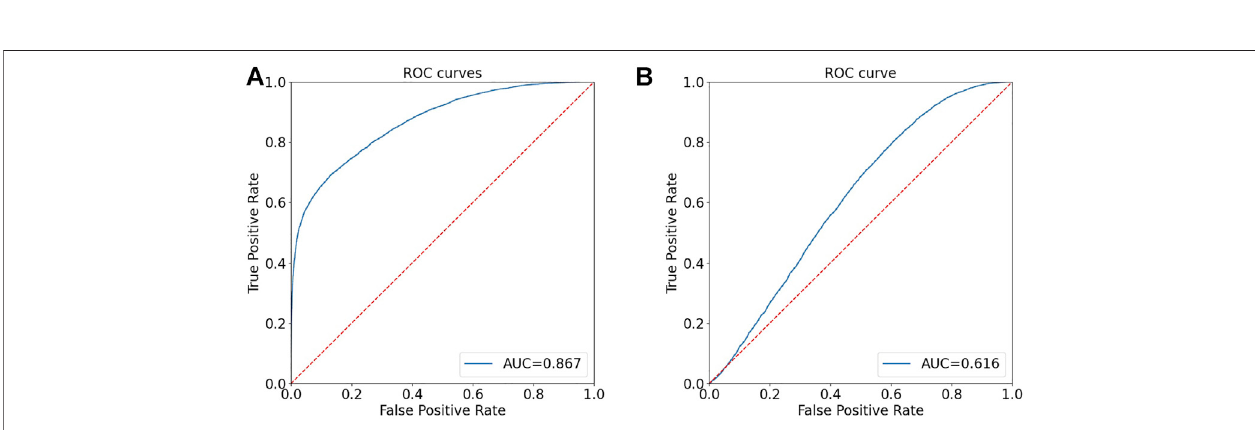
FIGURE 7 | Performance (AUC) on the Print&Scan image dataset: the proposed SNN-modi fi edXceptionNet (A) and ResNet50-NoDown (B) .